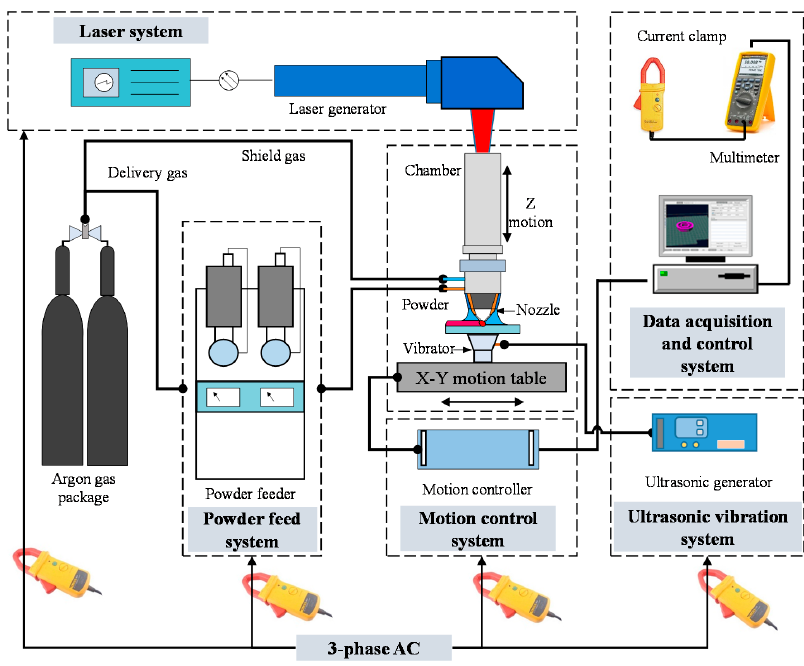
Figure 1. Illustration of experimental set ‐ up.